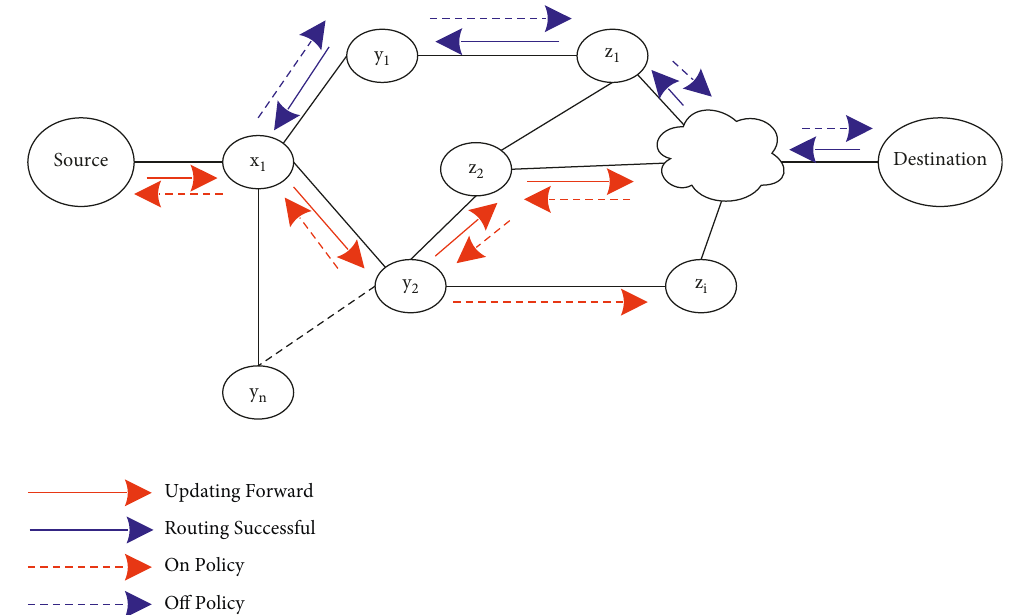
Figure 4: Nanonetwork with ACK